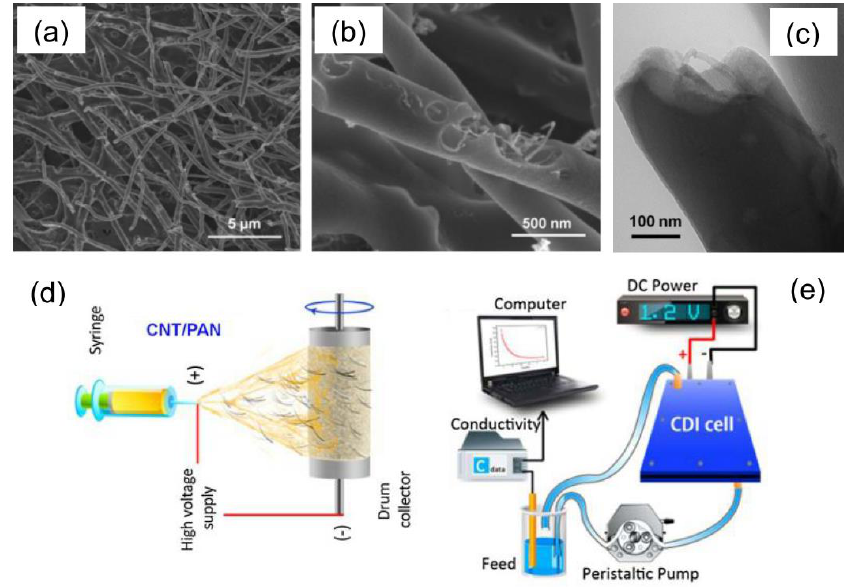
Figure 25. ( a , b ) SEM and ( c ) TEM images of the composite CNT/ACF material, consisting of CNTs embedded in activated carbon fibers (ACF), produced and tested by means of the setup schematically depicted in ( d , e ), respectively (reproduced from reference [206] with permission. Copyright 2014,